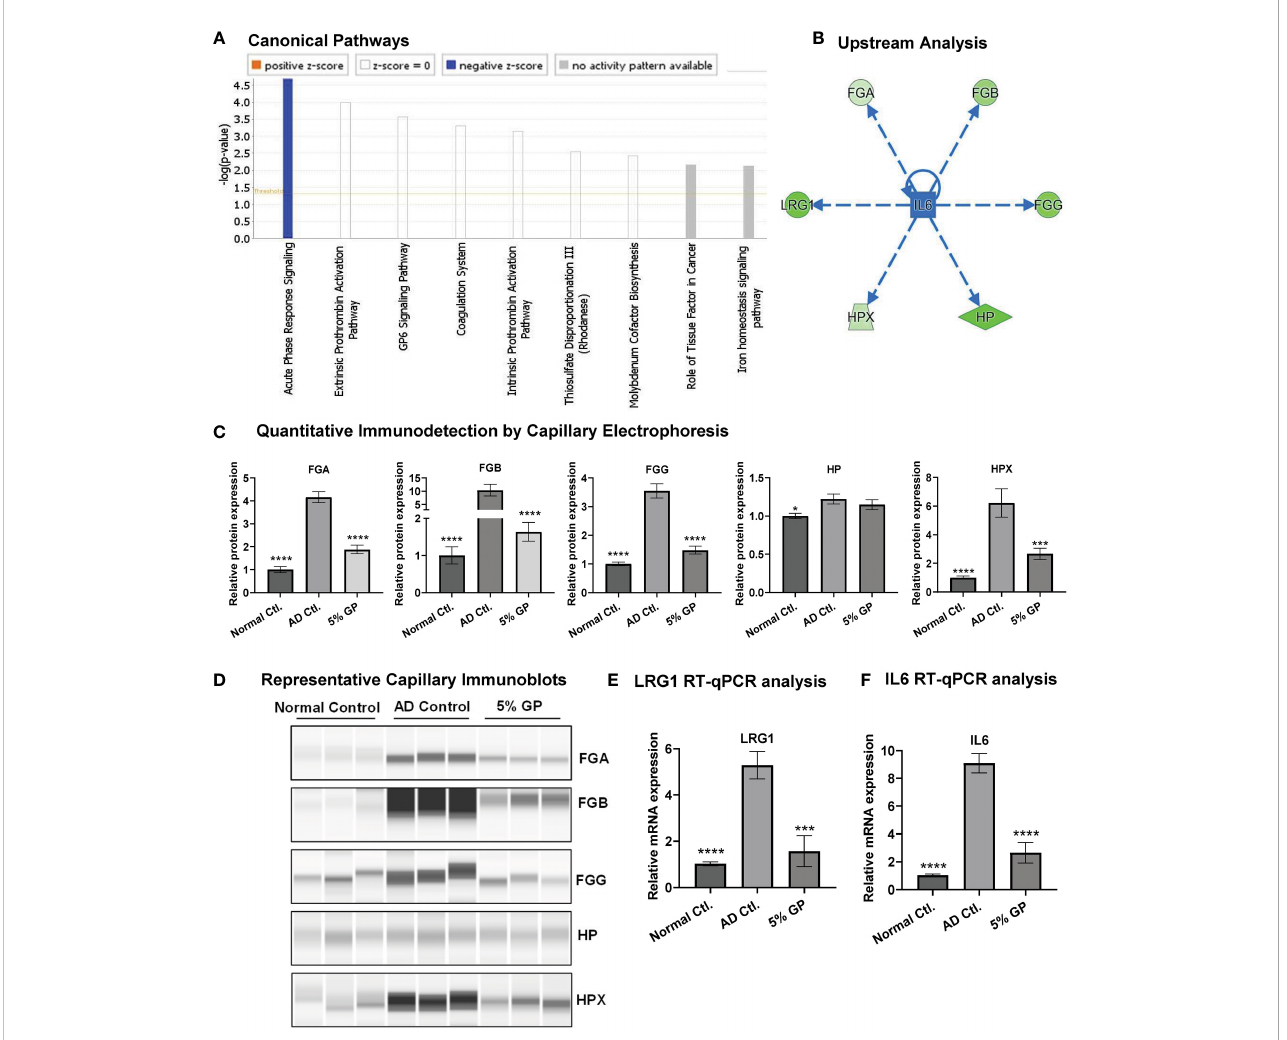
FIGURE 6 Effect of grape powder supplementation on acute phase response signaling in atopic dermatitis. (A) IPA was used to identify canonical pathways in responses to GP supplementation. Acute-phase response signaling was found with signi fi cant negative z-score. (B) IPA was also used to identify upstream regulator-related acute-phase proteins. (C, D) Validation of acute-phase proteins was performed using quantitative immunodetection by ProteinSimple Jess module as described in ‘ Materials and Methods ’ . The protein quantitative data were normalized to the total capillary area of ‘ Total Protein Assay ’ of the same sample. (E, F) Validation of LRG1 and IL6 using RT-qPCR analysis. ACTB was used as an endogenous control. All the quantitative data were analyzed using one-way ANOVA followed by Dunnett ’ s multiple comparison test. The data are presented as mean ± SEM of three biological pools (n = 6) and three technical replicates with statistical signi fi cance compared to AD control (*p<0.05, ***p<0.01,